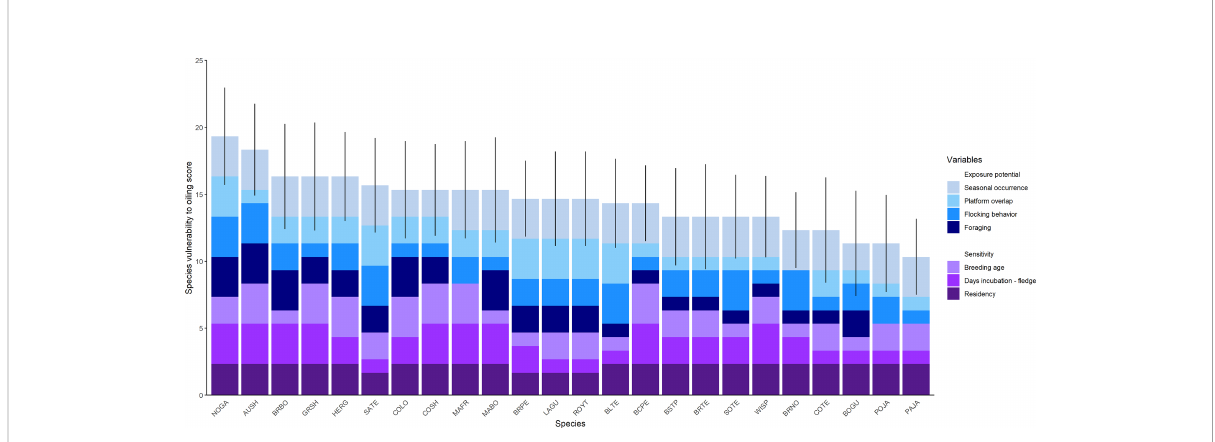
FIGURE 3 Cumulative vulnerability to oiling scores for seabirds in the northern Gulf of Mexico and the range of each cumulative score incorporating the uncertainty in the score of each variable. Species names are described in the ‘ species code ’ column of Table 4. Vertical lines indicate the range